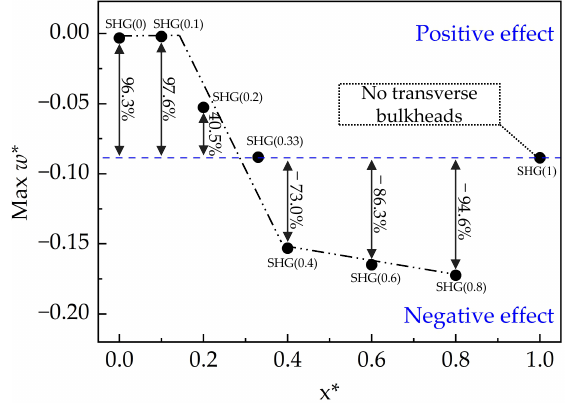
Figure 14. Maximum sagging deflection of different